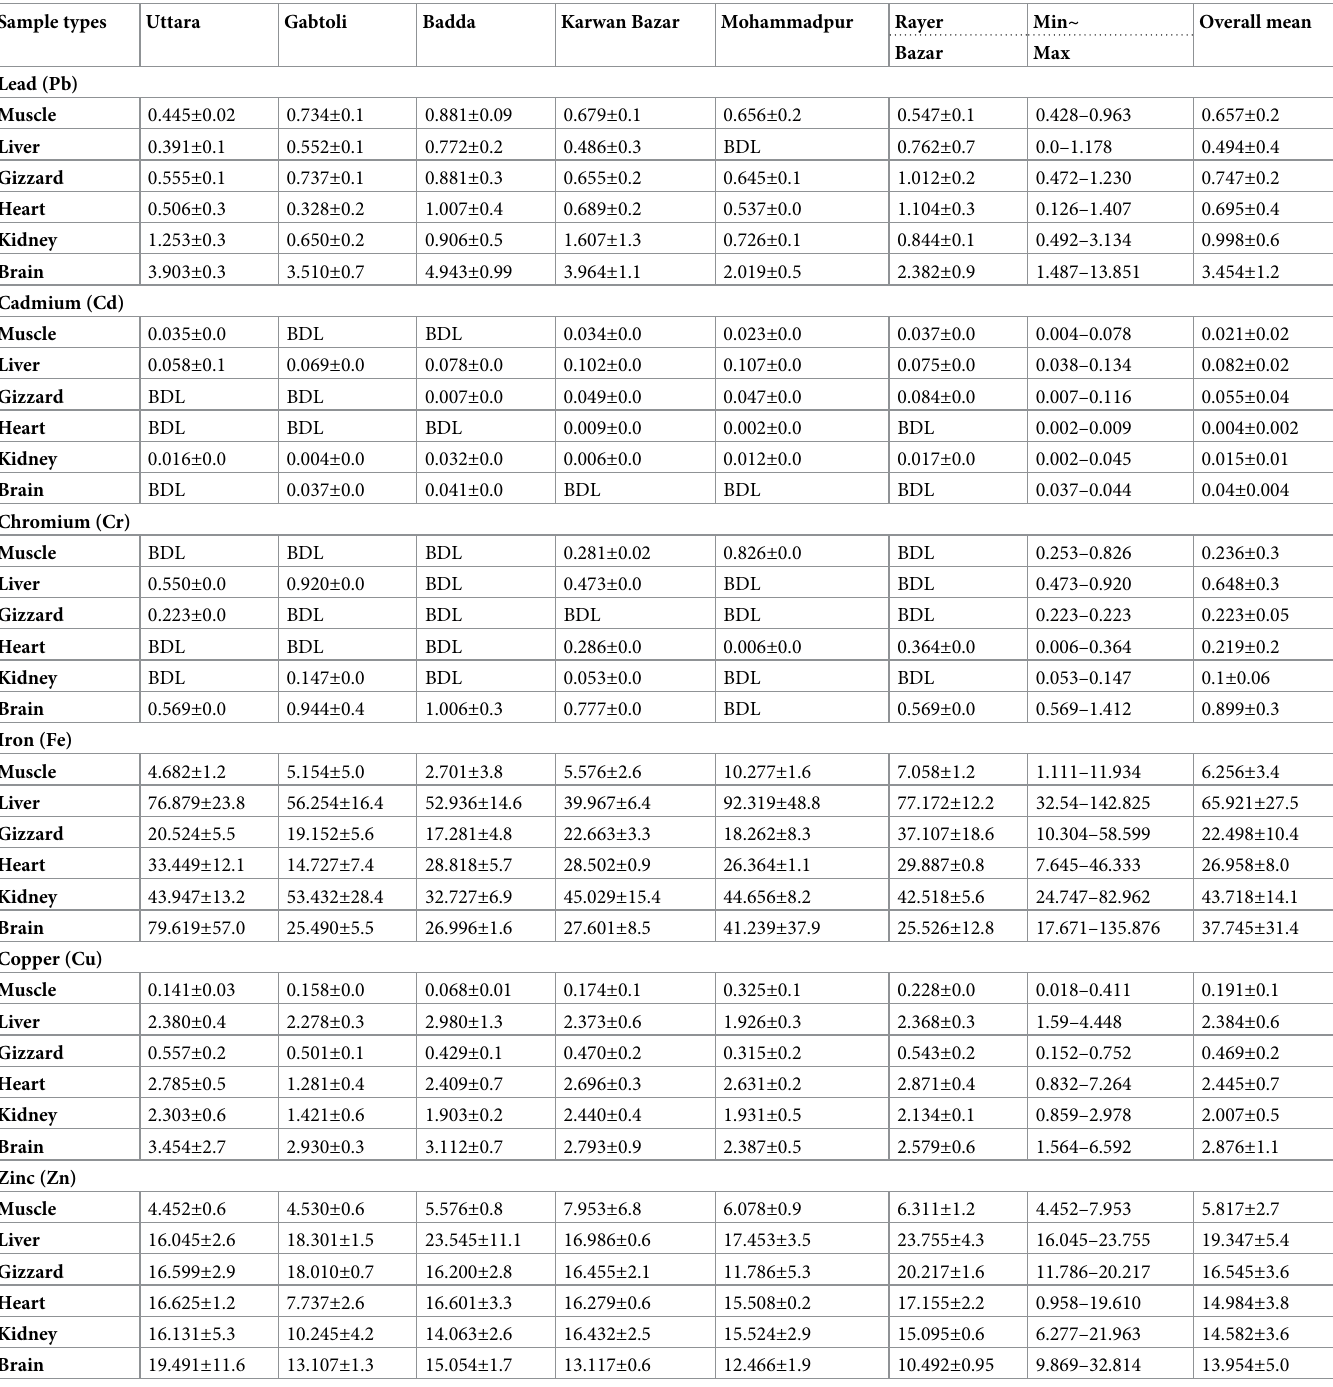
Table 2. The concentration of different heavy metals (mg/kg fresh weight) in broiler chicken from other regions of Dhaka North City Corporation (mean ± SD range). Sample